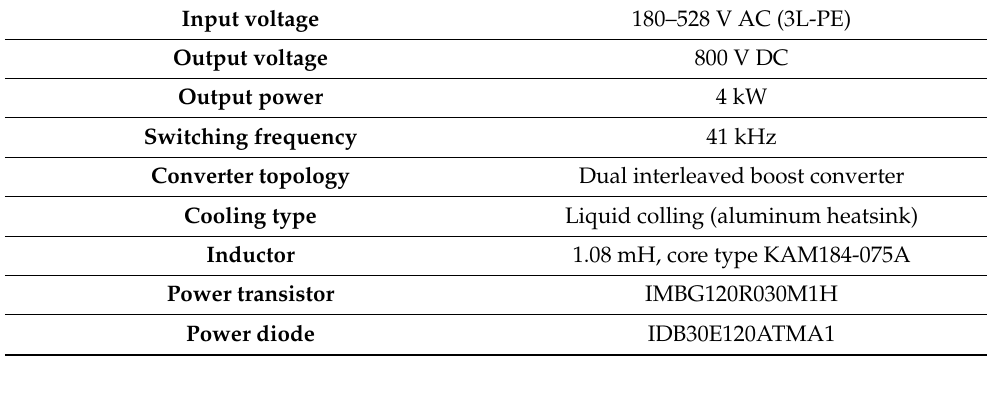
Figure 18. Principal schematic of PFC converter used for evaluation purposes. Table 3. Parameters of PFC converter used for experiments.